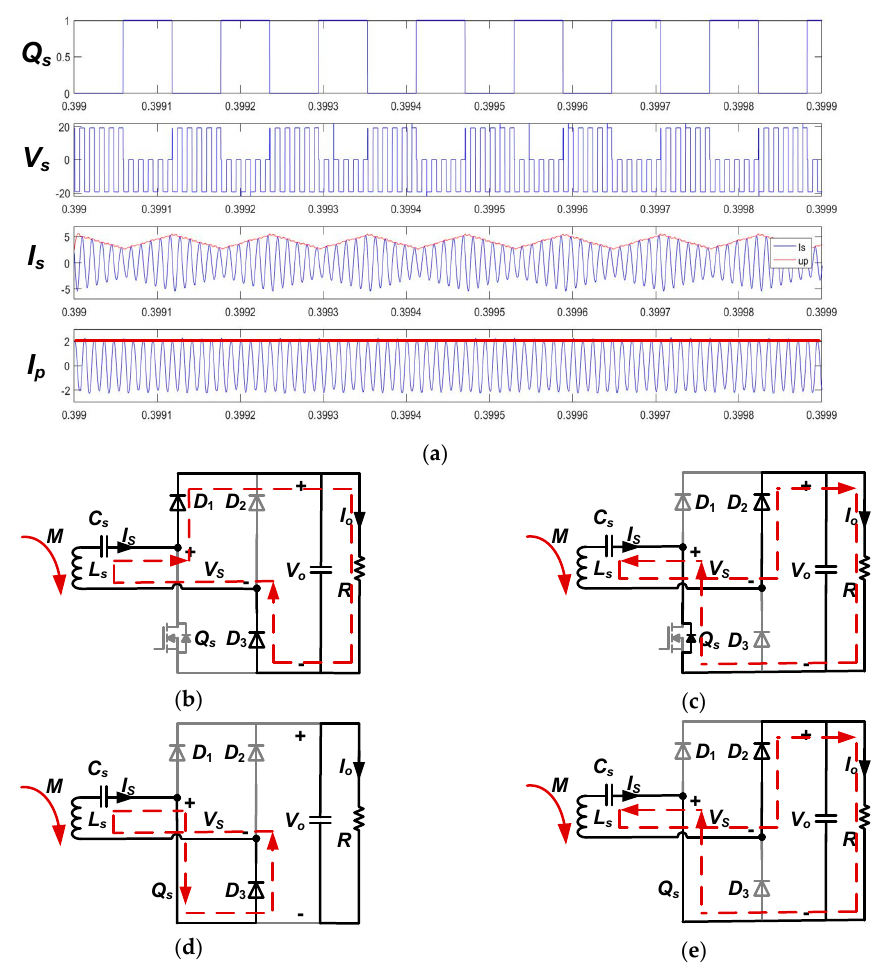
Figure 3. Typical waveforms and operation patterns of the SAB ( a ) waveforms of the SAB ( b ) current path when Q s is OFF and I s is positive ( c ) current path when Q s is OFF and I s is negative ( d ) current path when Q s is ON and I s is positive ( e ) current path when Q s is ON and I s is negative.